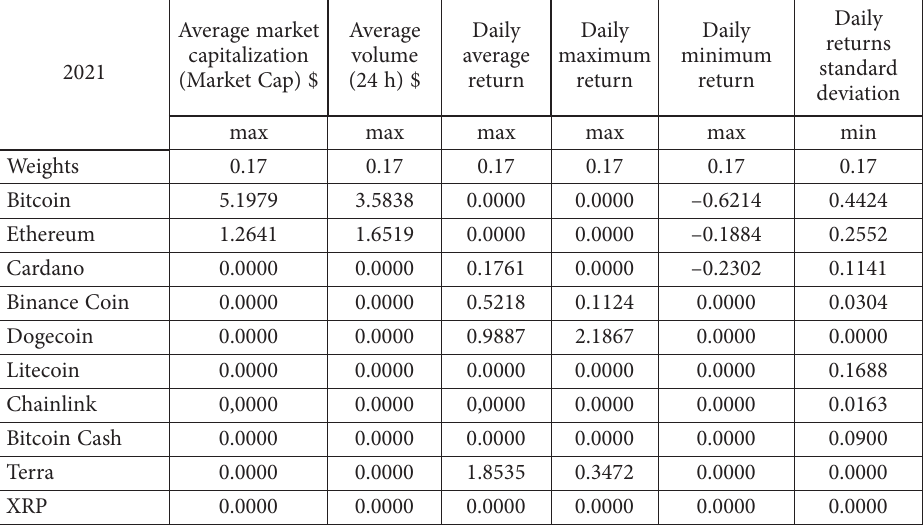
Table 3. PDA ij (source: compiled by the authors)